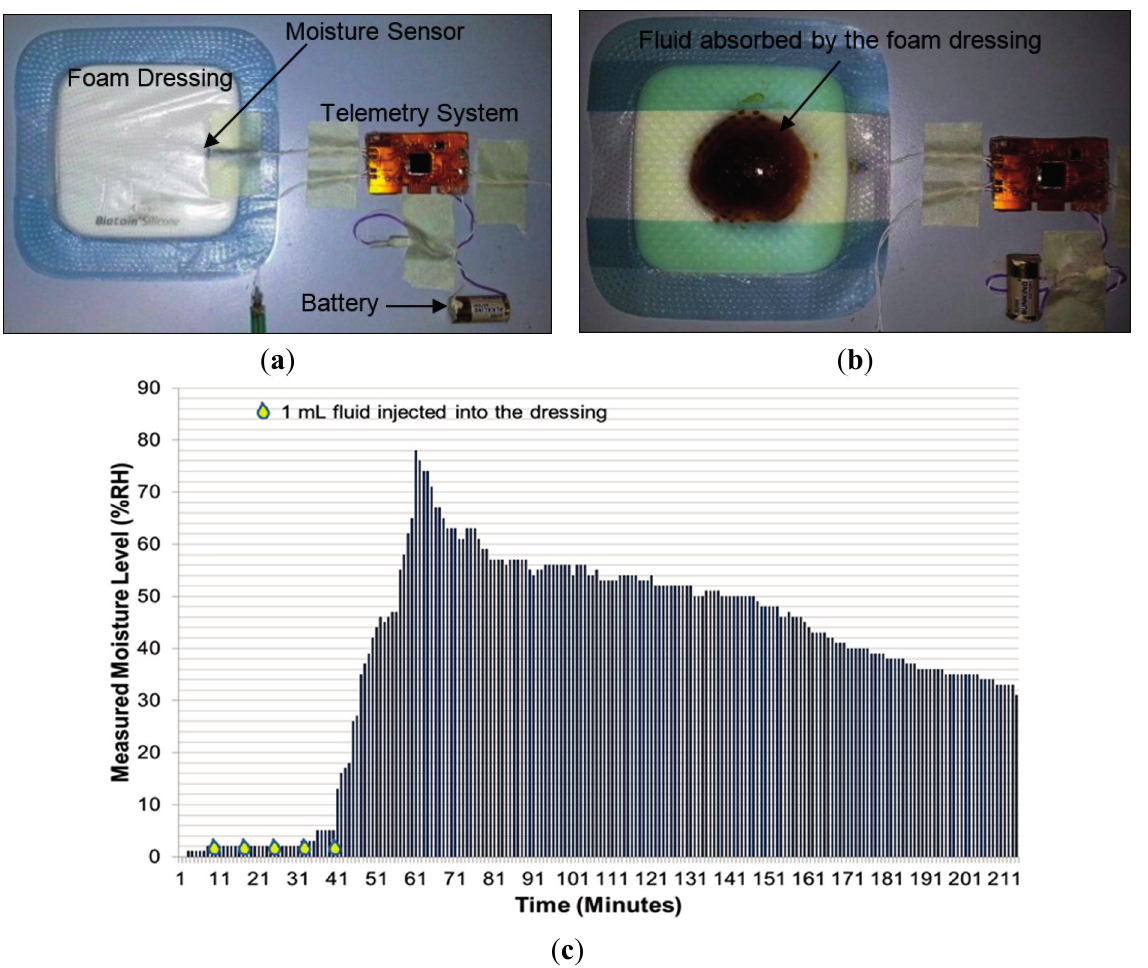
Figure 13. ( a ) Photo of moisture measurement setup showing the moisture sensor inserted into the foam dressing Biatain ® Silicone; ( b ) photo showing the spread of injected fluid into the dressing during the experiment; ( c ) graph showing the moisture measurement results during the whole